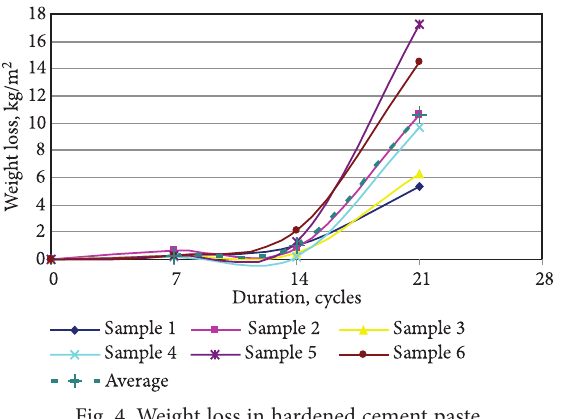
Fig. 4. Weight loss in hardened cement paste without SZ admixture